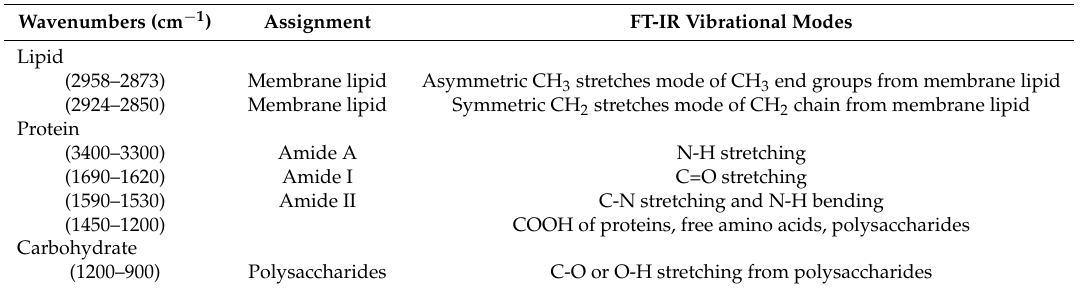
Figure 4. PC-DFA loadings plot from DF 2 of P. putida DOT-T1E strains in LB medium supplemented with or without 7 mM magnesium and 3 mM calcium in the absence and presence of 0.05% ( v/v ) toluene. Significant loadings were assigned to bacterial lipids (highlighted in the yellow box), proteins (blue box) and polysaccharides (red box). Table 1. Wavenumber regions of biological interest and assignment for P. putida DOT-T1E cells [66]. Wavenumbers (cm − 1 )